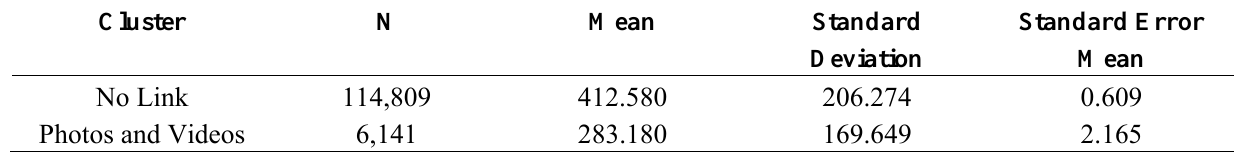
Table 7. Descriptive statistics: multimedia vs . no link (speed of